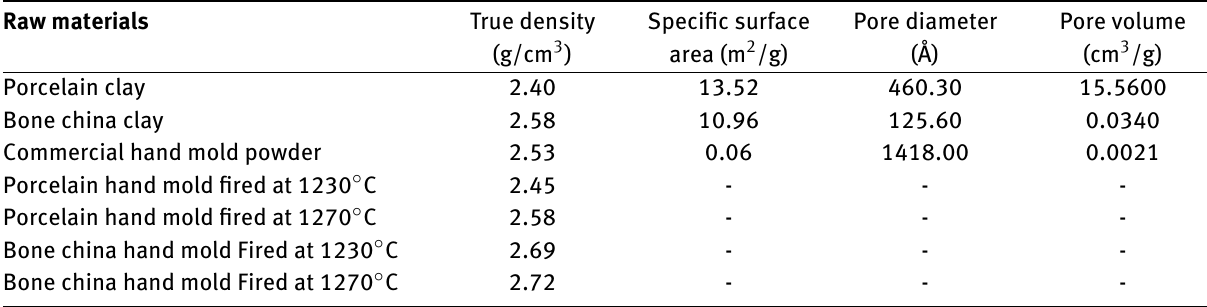
Table 2: Physical properties of raw materials and commercial hand mold Raw